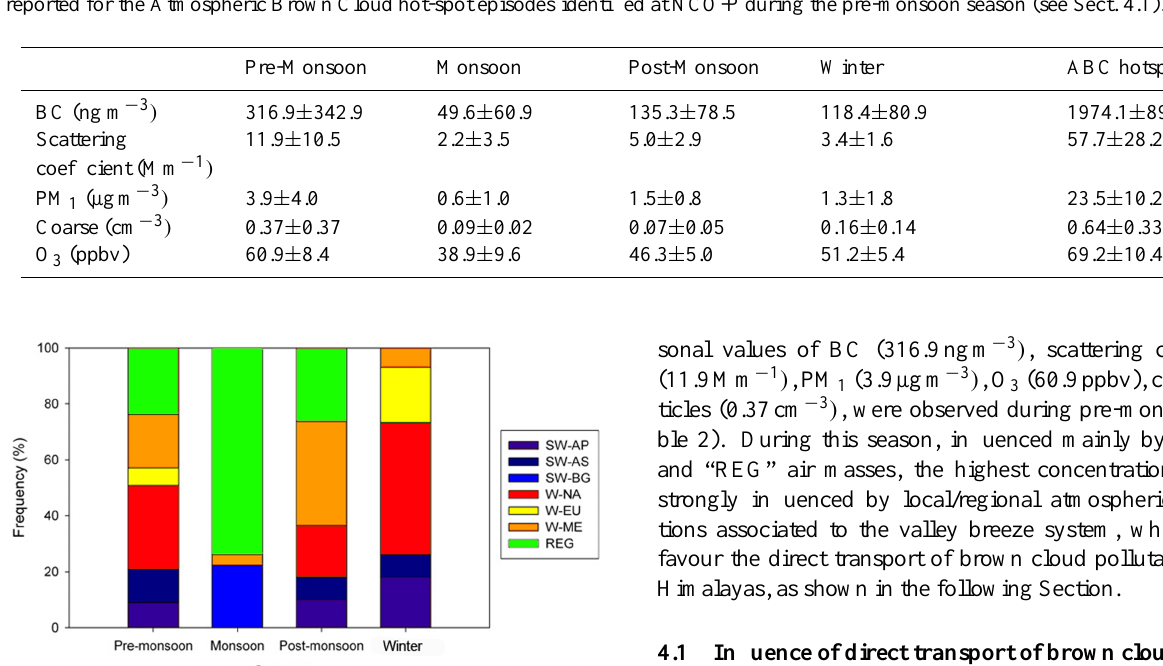
Table 2. Seasonal average (mean ± standard deviation) of BC, aerosol scattering coefficient, PM 1 , coarse particle number and O 3 at NCO-P during the period March 2006–February 2008. Seasons are defined following Table 1. In the last column, means ± standard deviations are reported for the Atmospheric Brown Cloud hot-spot episodes identified at NCO-P during the pre-monsoon season (see Sect. 4.1).